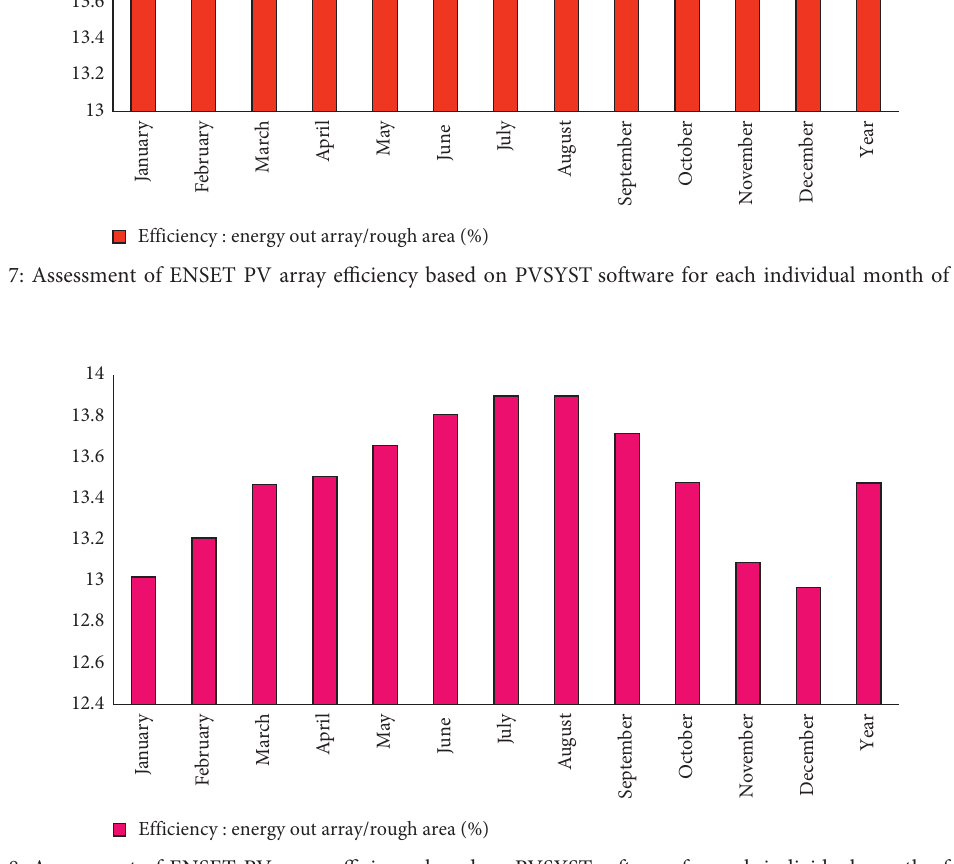
Figure 8: Assessment of ENSET PV array efficiency based on PVSYST software for each individual month of the year.